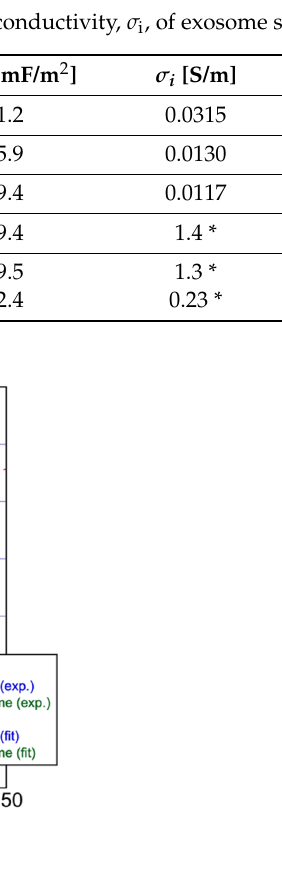
Figure 3. Plots of the crossover frequency against solution conductivity. Error bars indicate the standard deviation of the determined values of three independent experiments. The dotted lines are the best fitting curves to Equation (5).